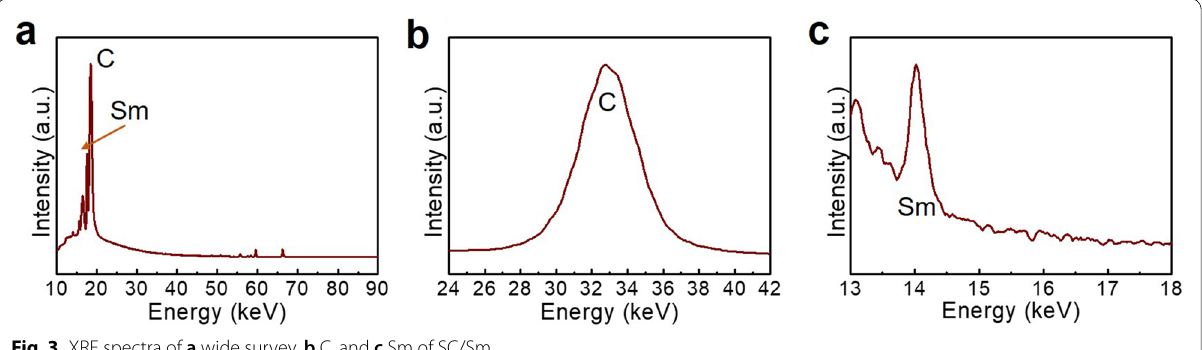
Fig. 3 XRF spectra of a wide survey, b C, and c Sm of SC/Sm